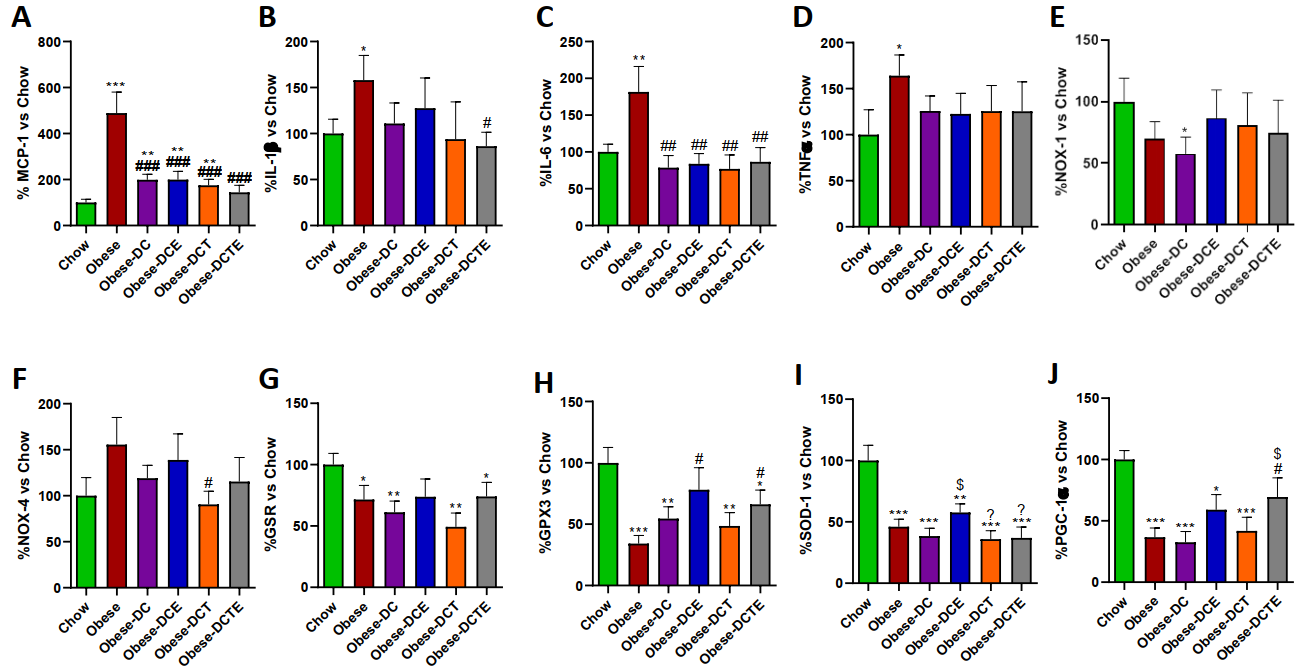
Figure 7. Gene expression of Monocyte Chemotactic Protein-1 ( A ), Interleukin 1 β ( B ), Interleukin 6 ( C ), Tumor Necrosis Factor α ( D ) NADPH oxidase 1 ( E ), NADPH oxidase 4 ( F ), Glutathione Reductase ( G ), Glutathione Peroxidase 3 ( H ), Super Oxide Dismutase 1 ( I ) and PPAR- γ coactivator 1 α ( J ) in visceral adipose tissue. Chow = mice fed a standard diet for 25 weeks; Obese = mice fed a high fat (60% kcal from fat)/high sucrose diet for 25 weeks; DC = mice fed a high fat (60% kcal from fat)/high sucrose diet for 23 weeks and switched to a diet with lower caloric intake (25% kcal from fat) for two weeks; DCE = mice fed a high fat (60% kcal from fat)/high sucrose diet for 23 weeks and switched to a diet with lower caloric intake (25% kcal from fat) supplemented with CSAT+ ® for two weeks; DCT = mice fed a high fat (60% kcal from fat)/high sucrose diet for 23 weeks and switched to a diet with lower caloric intake (25% kcal from fat) and subjected to aerobic training for two weeks; DCTE = mice fed a high fat (60% kcal from fat)/high sucrose diet for 23 weeks and switched to a diet with lower caloric intake (25% kcal from fat) supplemented with CSAT+ ® and subjected to aerobic training for two weeks. Values are represented as mean ± SEM; n = 8–10 mice/group. * p < 0.05 vs. chow; ** p < 0.01 vs. chow; *** p < 0.001 vs. chow; # p < 0.05 vs. obese; ## p < 0.01 vs. obese; ### p < 0.001 vs. obese; $ p < 0.05 vs. obese-DC. ? p < 0.05 vs.